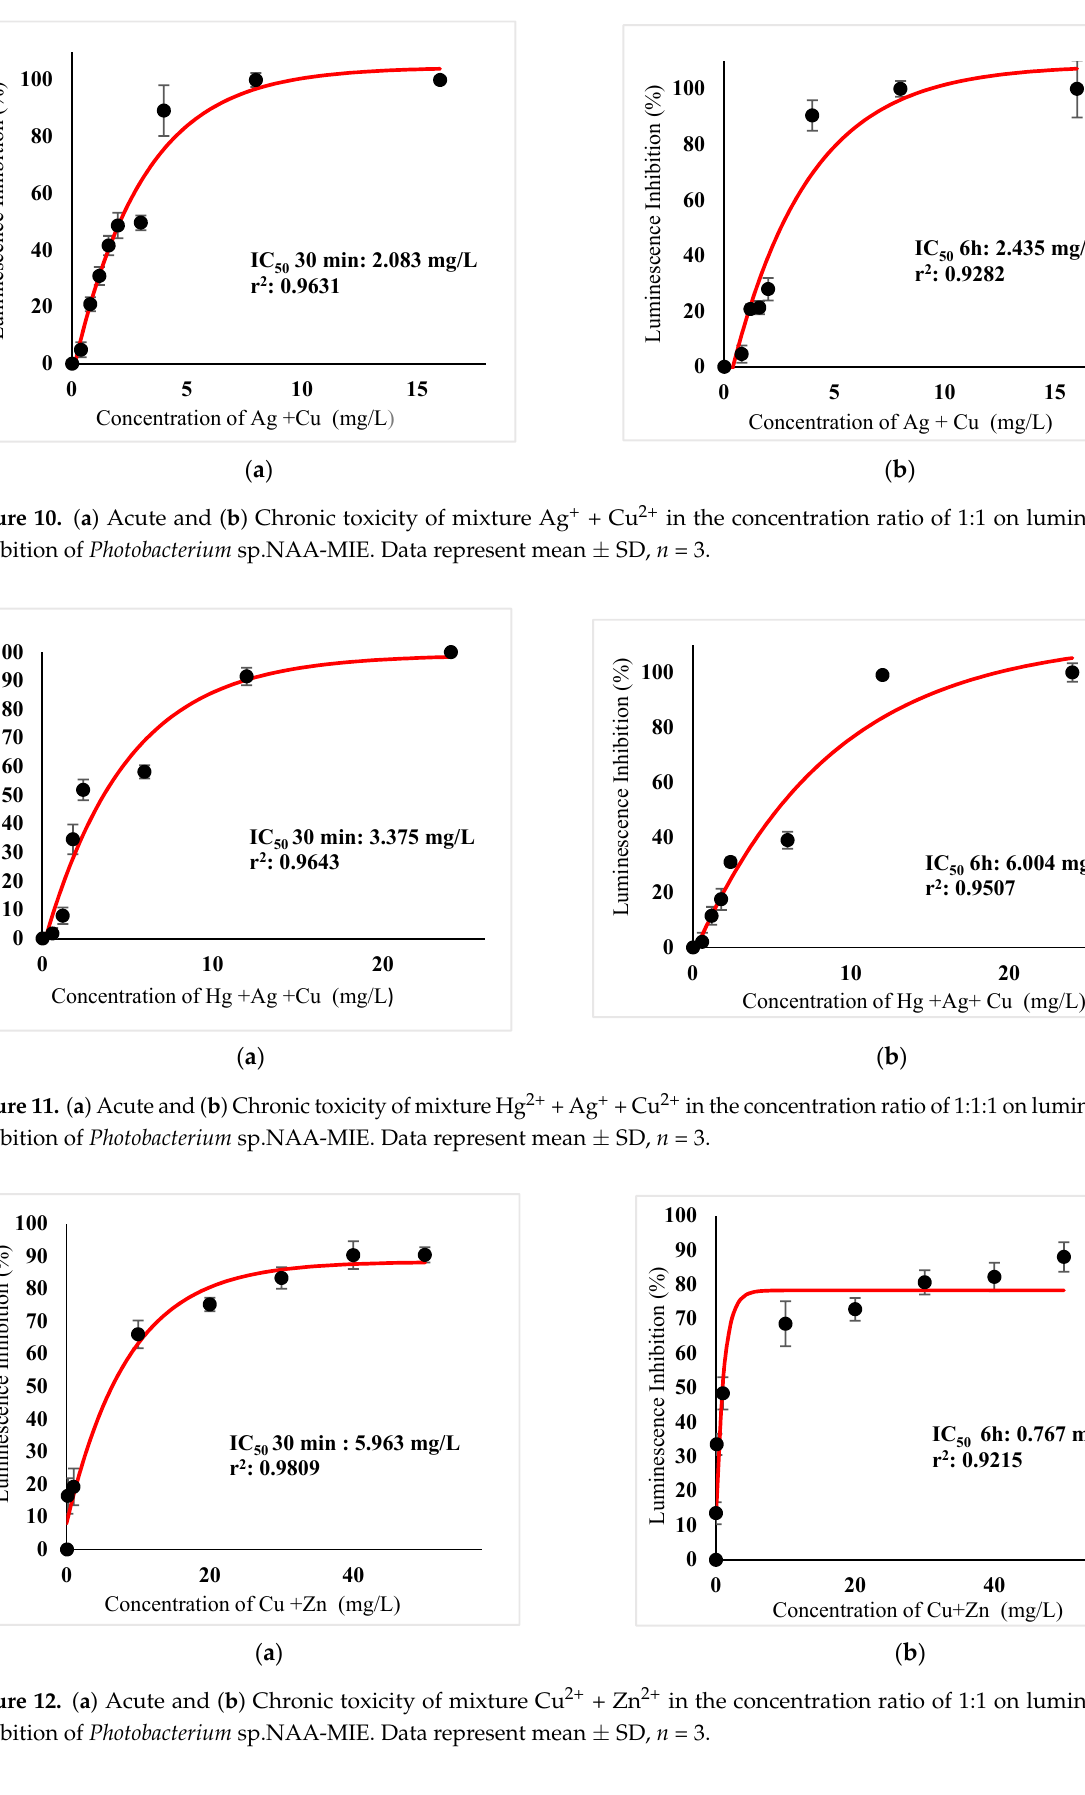
Figure 9. ( a ) Acute and ( b ) Chronic toxicity of mixture Hg 2+ + Cu 2+ in concentration ratio of 1:1 on luminescence inhibition of Photobacterium sp.NAA-MIE. Data represent mean ± SD, n = 3.